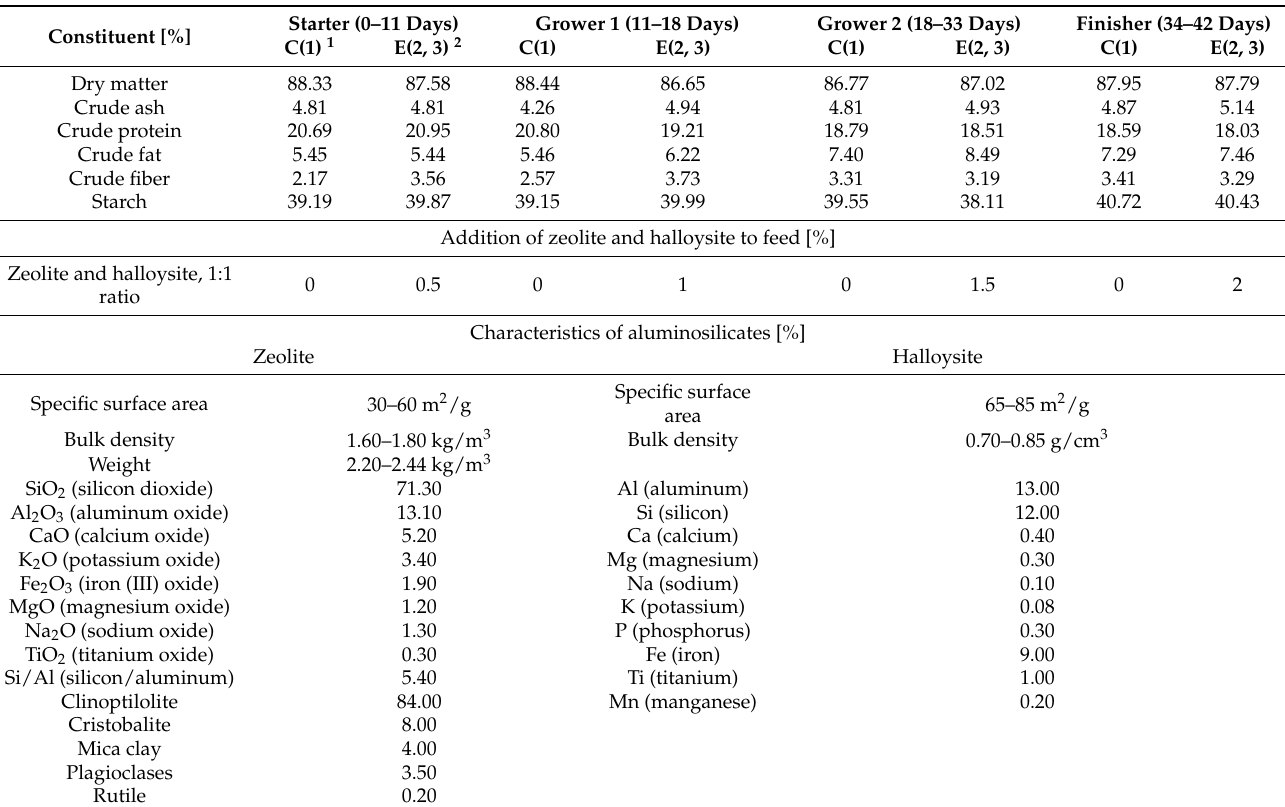
Table 1. Analytical composition of feeds for broiler chickens (4 feeding phases) and characteristics of